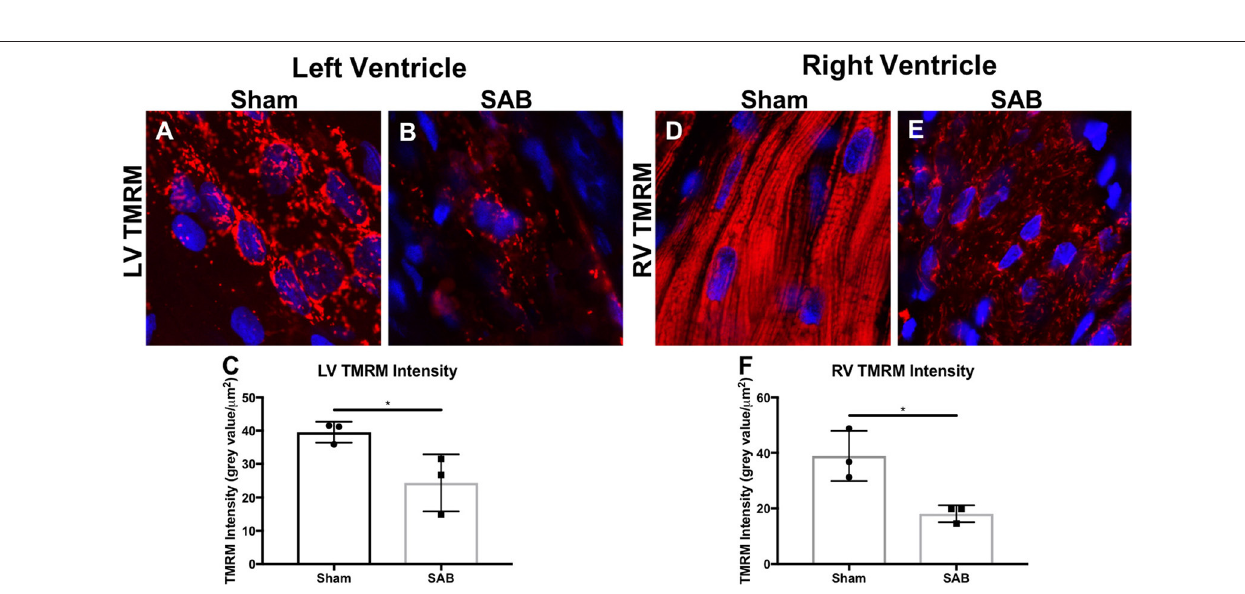
FIGURE 4 | Representative confocal microscopy image showing left ventricular (LV) and right ventricular (RV) mitochondrial morphology and membrane potential of (A,D) sham rats vs. (B,E) supra-coronary aortic banding rats. The mitochondria (red) are labeled with tetramethylrhodamin, methyl ester (TMRM) and the nuclei (blue) are labeled with DAPI. (C) LV and (F) RV TMRM intensity. Each dot represents a heart from a unique rat.